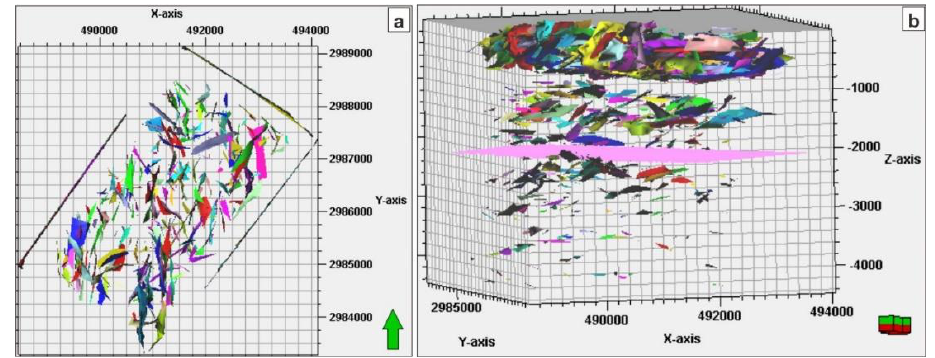
Figure 17. ( a ) 2D view of extracted fracture surfaces and ( b ) 3D view of the automatic fracture network by ACO. The inserted time slice (pink color) at 2176 ms was used to differentiate the fractures above and below this horizon.